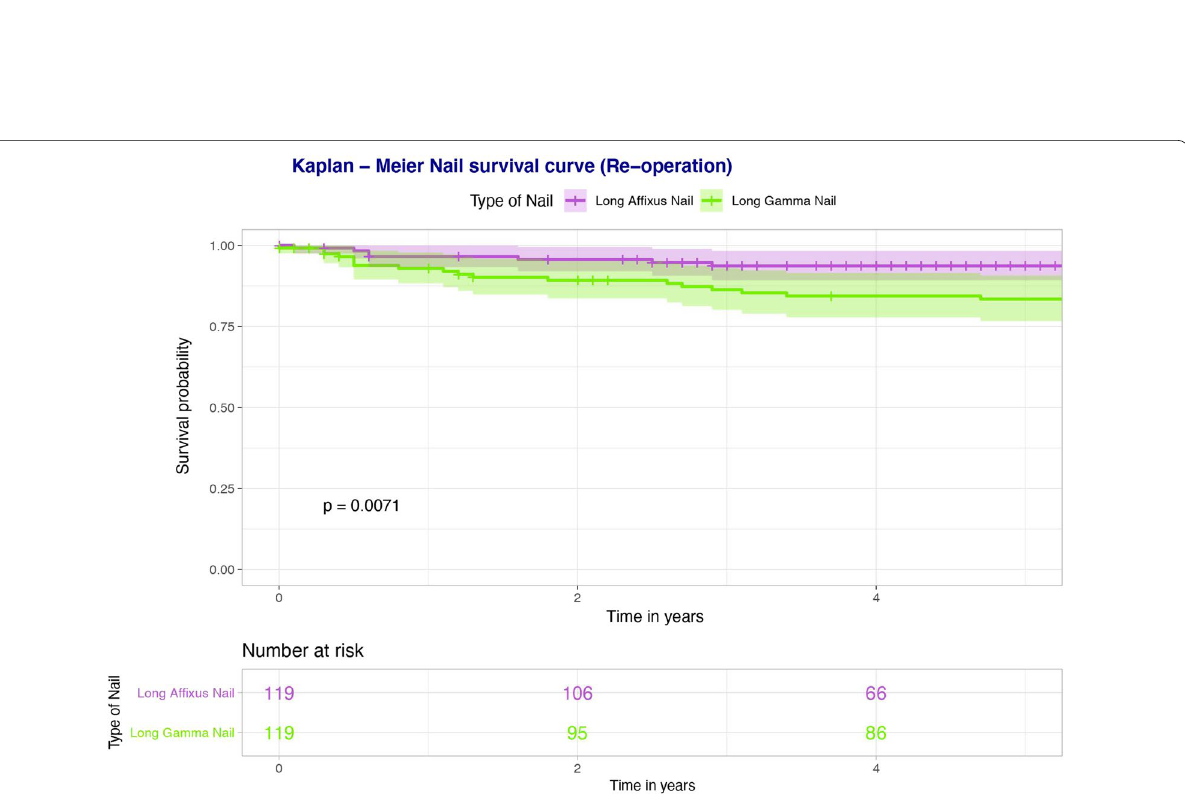
Fig. 4 Kaplan–Meier survival curve of re-operation secondary to any cause. The height of each KM curve represents the 95% confidence interval for each